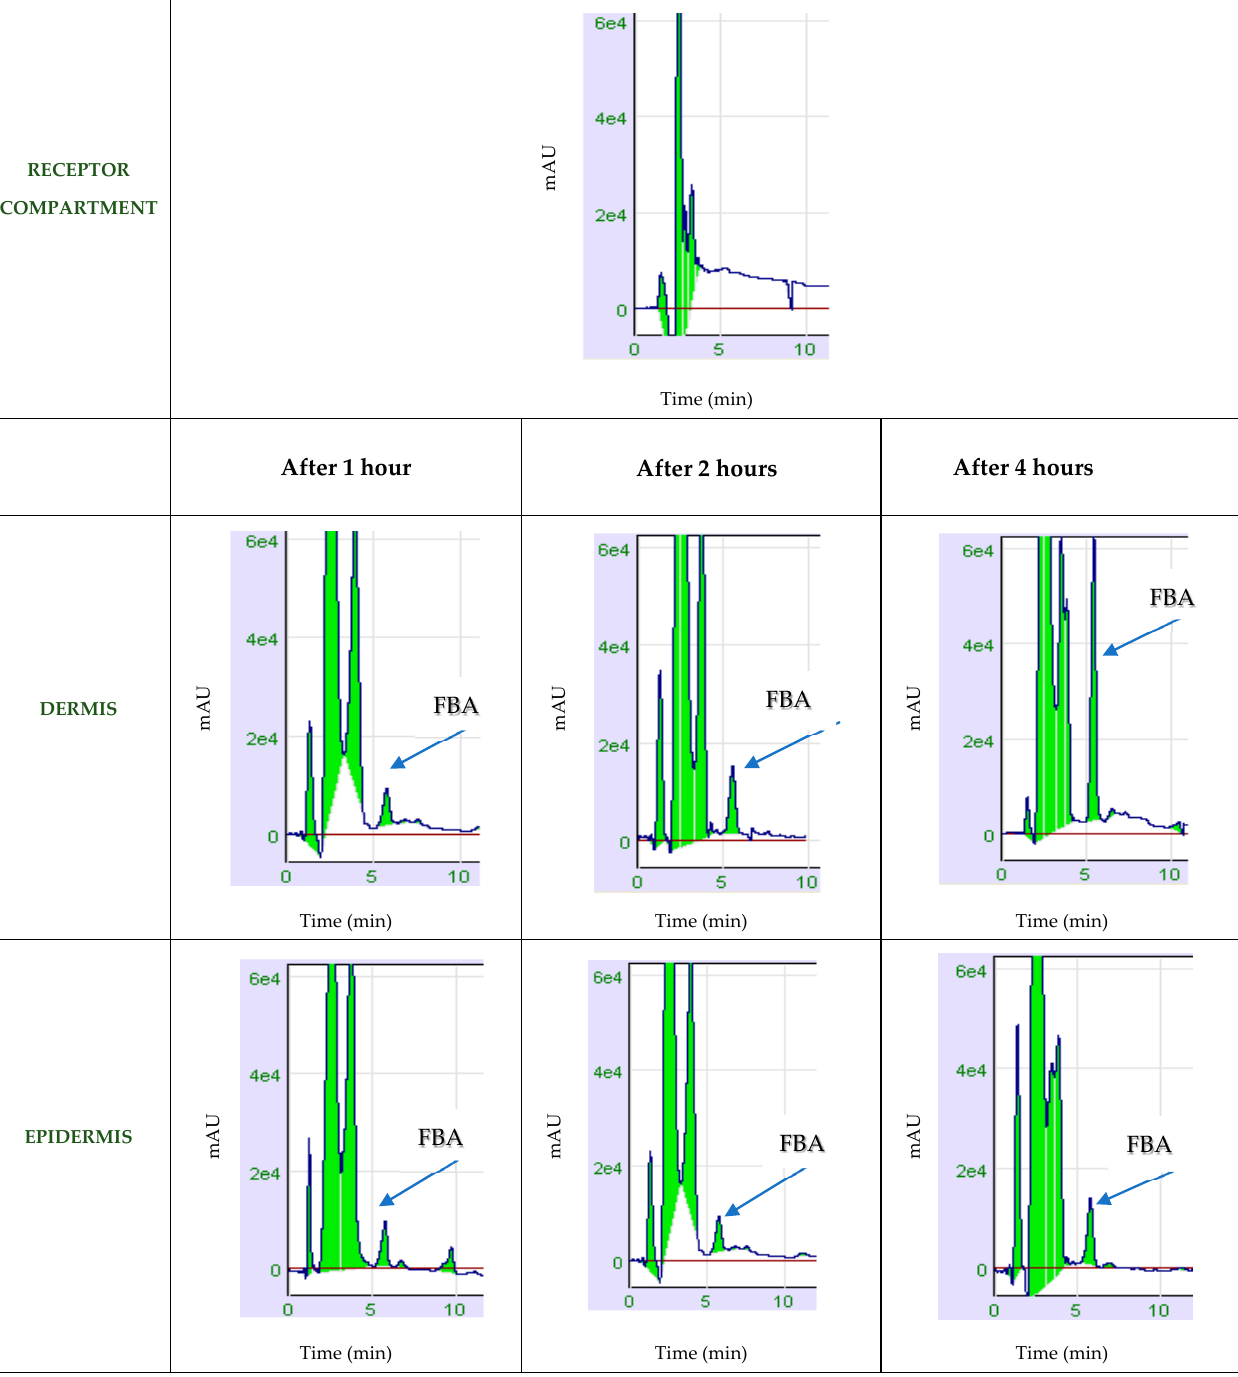
Figure 2. Chromatograms related to the determination of FBA levels in the skin. There was a decrease in skin redness values on the control site ( − 8.6% after 30 (cid:48) and − 10.5% after 60 (cid:48) ), and on the placebo site ( − 8.8% after 30 (cid:48) and − 11.8% after 60 (cid:48) ). Moreover, a significative erythema index decrease ( − 15.7% after 30 (cid:48) and − 17.8% after 60 (cid:48) ) was detected after applying the emulsion containing FBA (Table